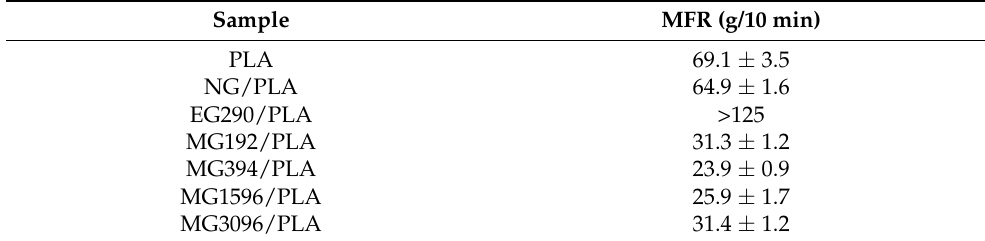
Table 5. MFR values with standard